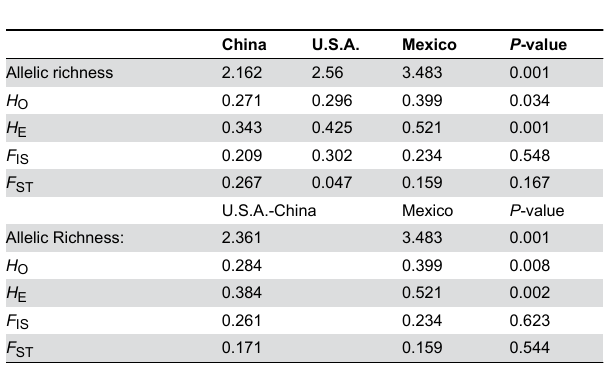
Table 3. Comparison of genetic diversity across geographic regions.